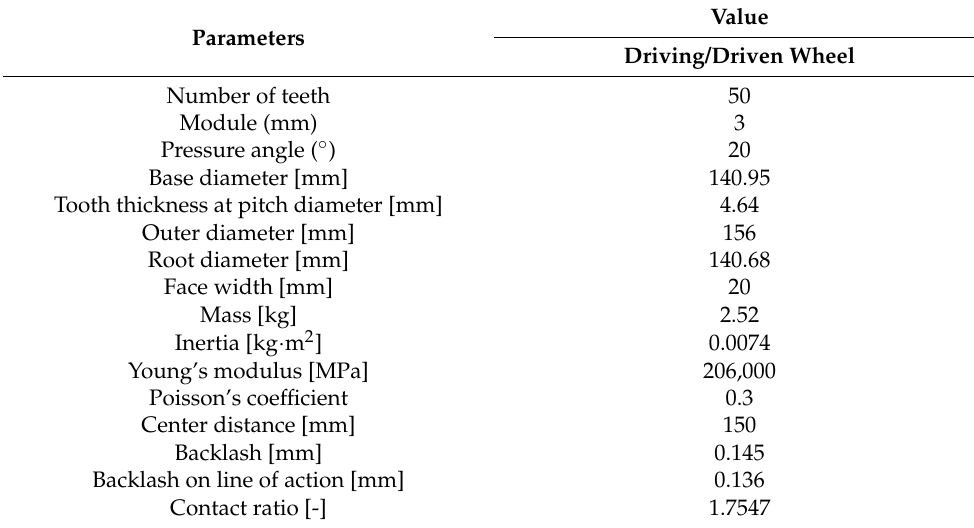
Table 1. Basic parameters of gears.